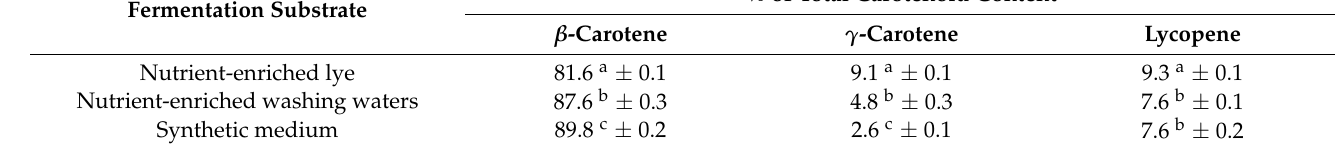
Table 3. Proportion of β -carotene, γ -carotene, and lycopene at the maximum carotenoid production by B. trispora grown in non-sterile lye and washing waters after enrichment with nutrients as well as in synthetic medium (fermentation time: 6 days).